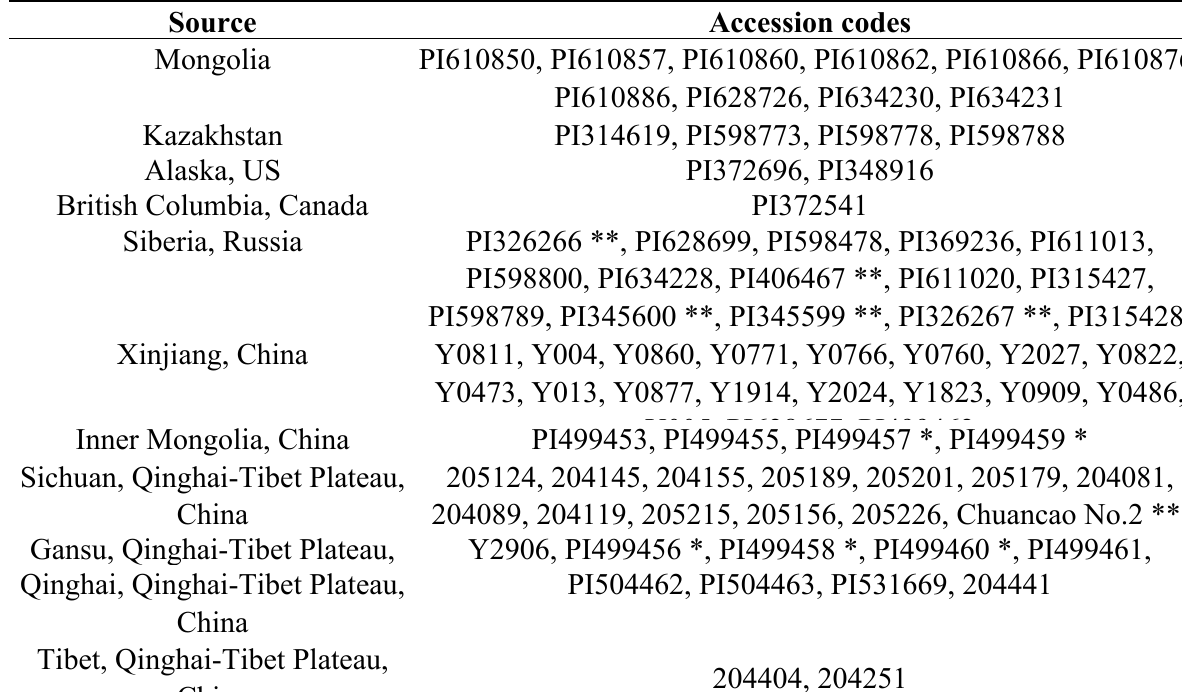
Table 1. Description of the 86 E. sibiricus accessions used in this